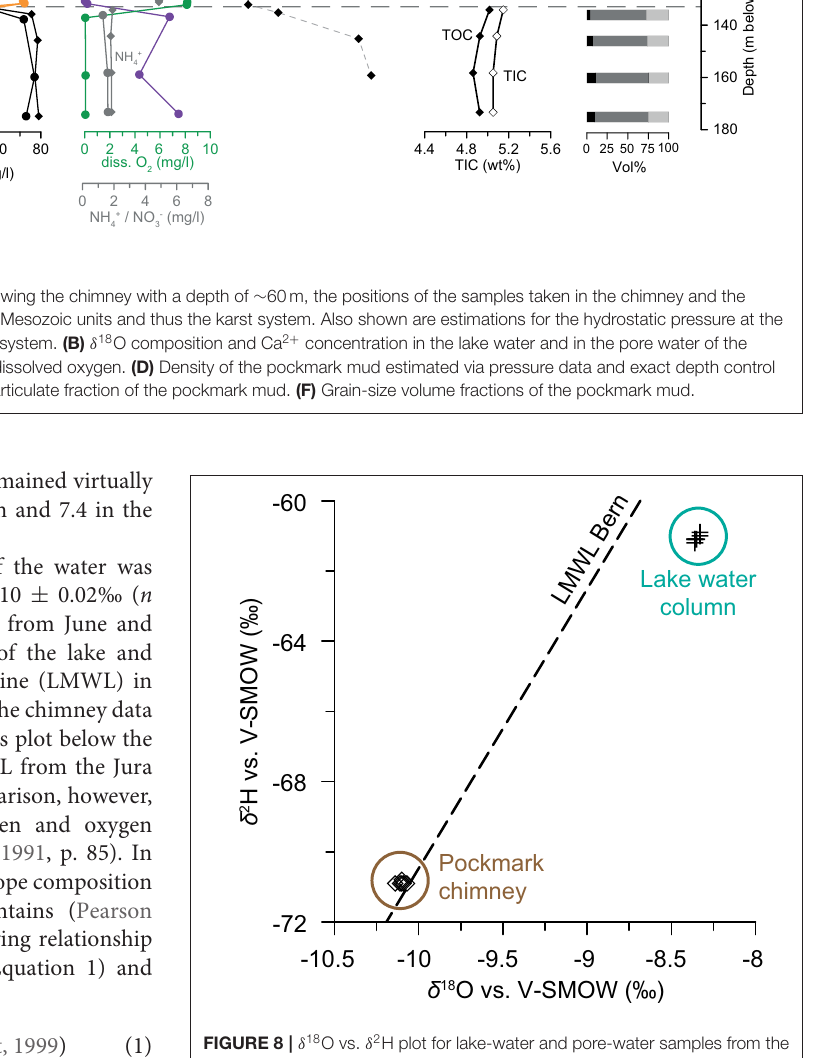
FIGURE 8 | δ 18 O vs. δ 2 H plot for lake-water and pore-water samples from the CB chimney compared to the LMWL of Bern (GNIP data). In contrast to the lake-water samples the plot indicates no evaporation for the pockmark samples, what underlines the groundwater character of the pockmark